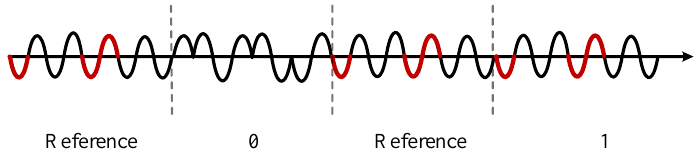
Figure 10. Illustration of On–Off keying-based